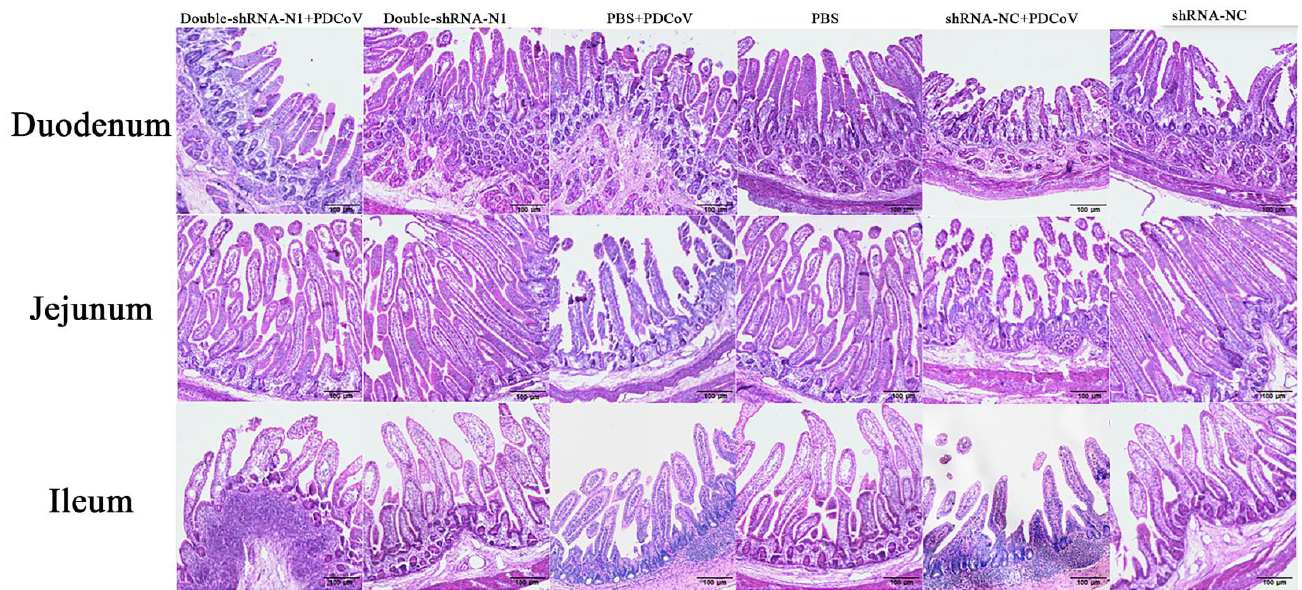
Figure 9. shRNA−expressing plasmids protect piglets from histopathological lesions induced by PDCoV. The small intestines of all piglets were collected for histopathological examination.